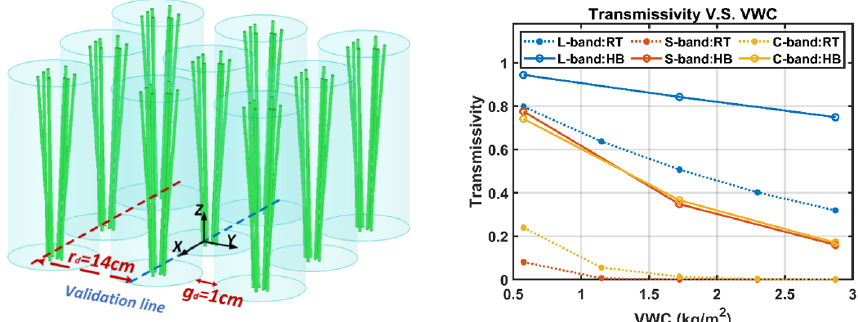
Figure 9. (a) Scattering from wheat plants is the radius of the circumscribing cylinder (6.5cm), distance between the centers of two circum- scribing cylinders is r d = 14cm, and the closest distance between two circumscribing cylinders is g d = 1cm. The figure is adapted from Gu et al. (2021). (b) Transmission of microwave through wheat of different orientation calculated using the hybrid method and the RTE varies with volume water content